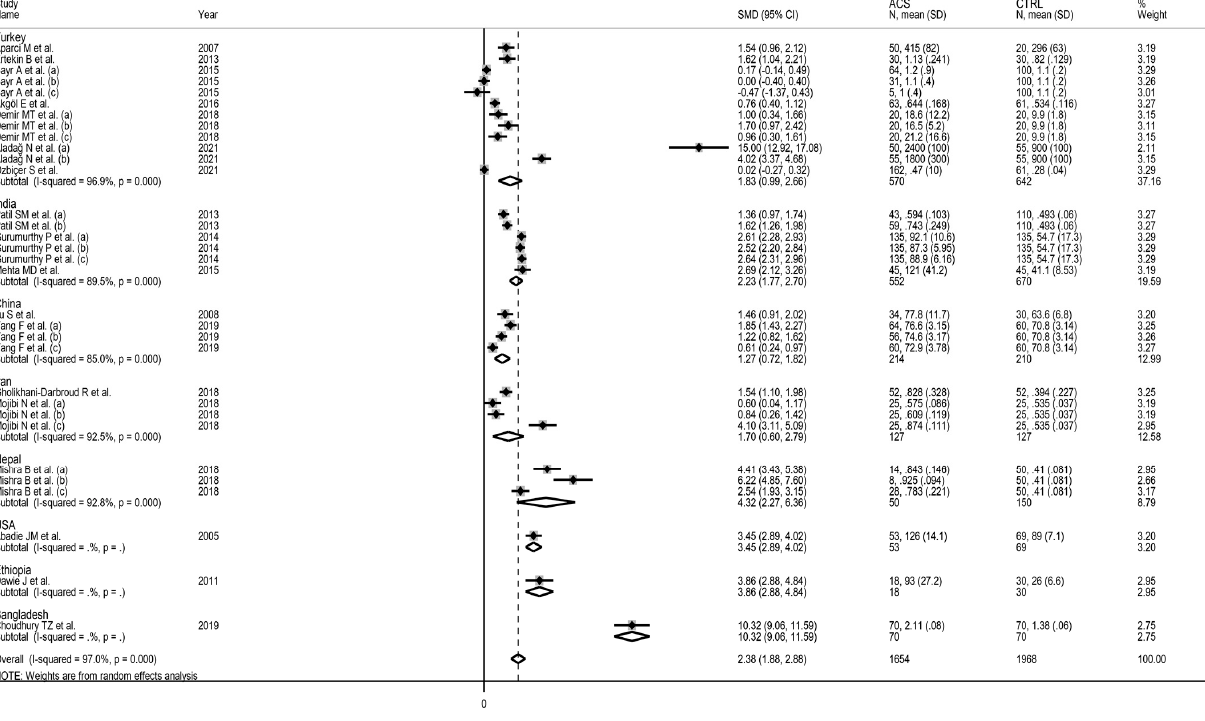
Figure 8. Forest plot of studies examining ischaemia-modified albumin according to the country where the study was